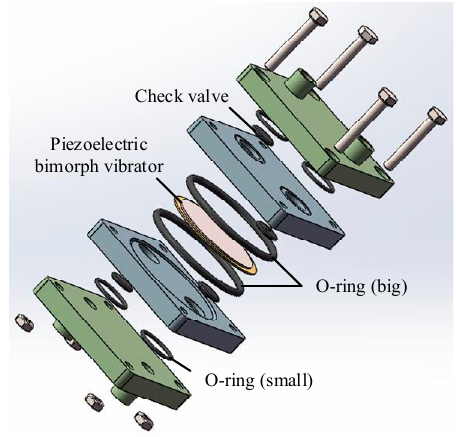
Figure 3. The 3-D assembly schematic of the DSPPIS.